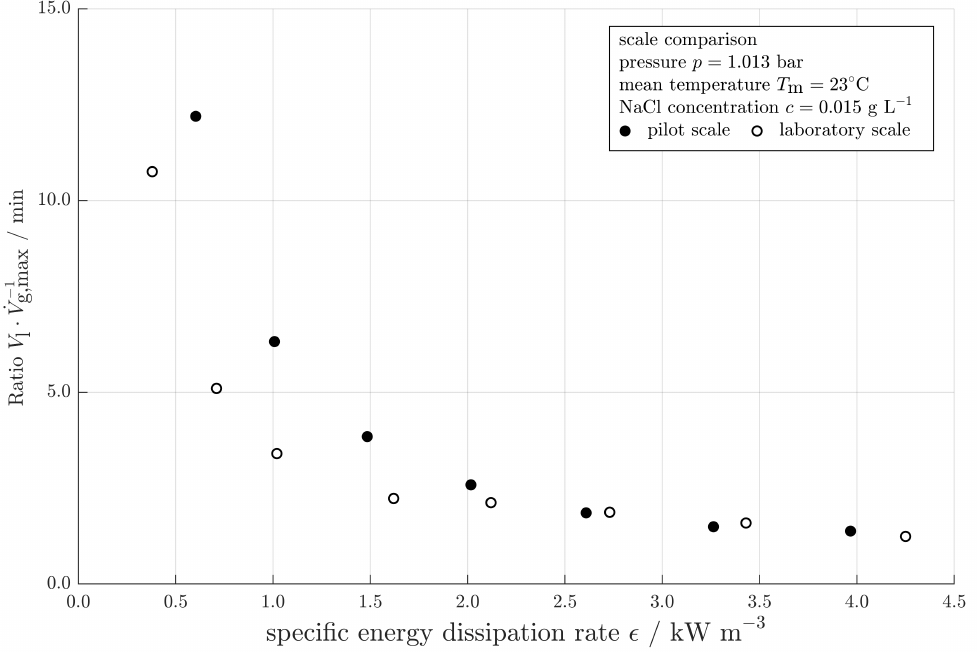
Figure 9. Comparison of the maximum achievable gassing rates ˙ V g,max in form of the ratio V l · ˙ V − 1 g,max for the two investigated scales of the reactor for different specific energy dissipation rates (cid:101) . Both systems show a quite similar behaviour, with deviations for lower specific energy dissipation rates. Here, the laboratory system can form a stable loop for relatively higher gas volume flow rates. This seems curious at first, when it is taken into account that bubble sizes for high gassing rates are in similar ranges (except for coalesced outliers). But